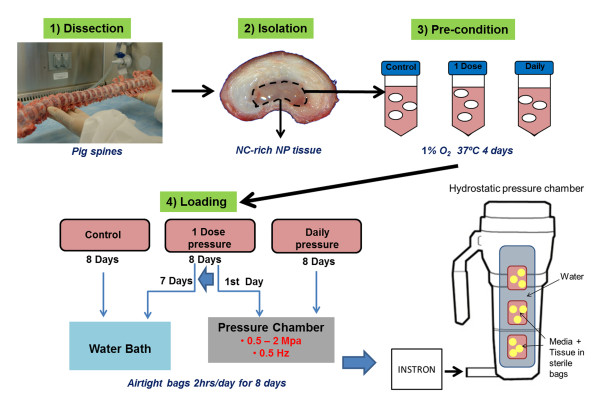
Schematic of the tissue isolation and loading protocol. Pig spines were dissected aseptically and the notochordal cell (NC)-rich nucleus pulposus (NP) tissue was isolated and preconditioned for 4 days in 1% oxygen, 5% carbon dioxide at 37°C in Dulbecco's modified Eagle's medium with 1× insulin transferrin and selenium. NP tissue was divided into three groups (Control group, 1 Dose pressurization group, Daily pressurization group) and placed in airtight Whirl-Pak bags (Nasco, Thermo Fisher Scientific, Waltham, MA, USA) for loading. The Control group was placed in a 37°C water bath for 2 hours every day for 8 days. The 1 Dose group was placed in a custom hydrostatic pressure chamber attached to an Instron 8511 servo hydraulic tension/compression system (Instron, Norwood, MA, USA) for 2 hours on 1 day with 0.5 to 2 MPa load at 0.1 Hz and then in the water bath for 2 hours each day thereafter [38]. The Daily pressurization group was placed in the chamber for 2 hours each day for 8 days with same loading regime as the 1 Dose group.